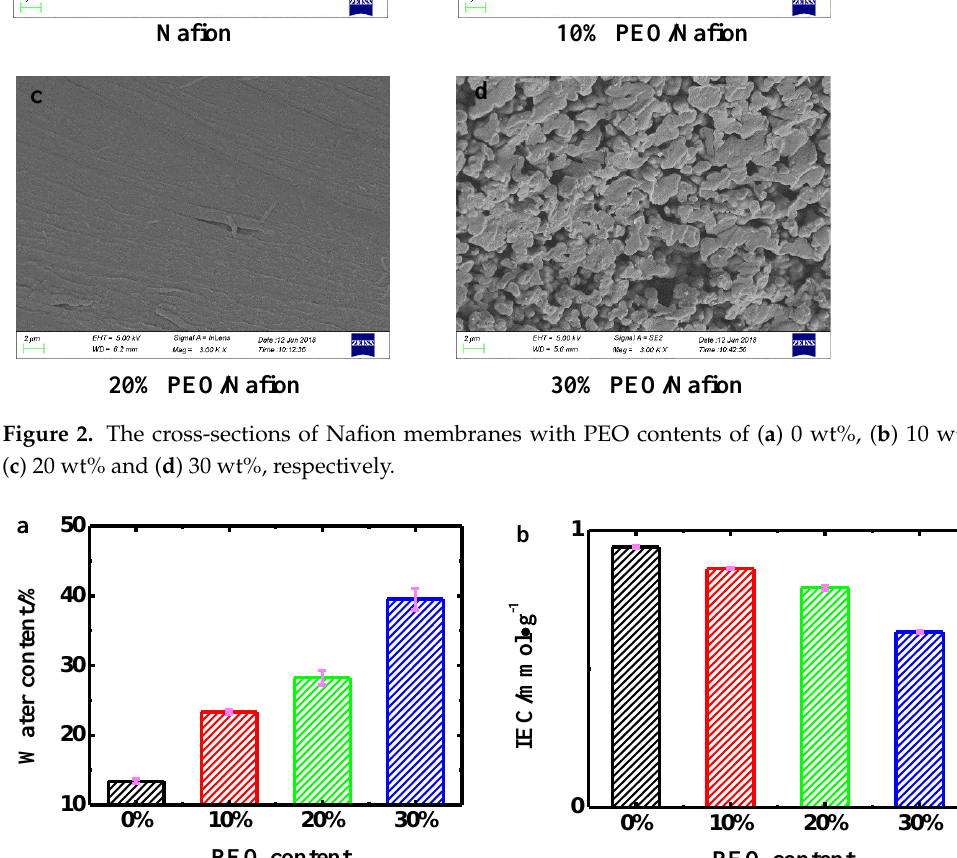
Figure 4. Equivalent stiffness of PEO/Nafion − IPMC with varying PEO contents. The deformation performance is one of the most important factors in evaluating the electromechanical performance of IPMC. Figure 5 records the peak − to − peak displacement of the PEO/Nafion − IPMC actuators under DC voltage with the amplitude of 2 V within 25 s. Obviously, doping PEO in the Nafion membrane dramatically affected the displace- ment property. Figure 6 reveals that the peak − to − peak displacements of all the PEO/Nafion − IPMCs were larger than those of the pure Nafion − IPMC due to higher WUR and lower equivalent stiffness of the PEO/Nafion membrane. It can be noticed that the average peak − to − peak displacement of PEO/Nafion − IPMC with 20 wt% PEO reached up to 11.00 mm, which was almost twice as large as that of the pure Nafion − IPMC (5.62 mm). This result indicated that the IPMC with a PEO content of 20 wt% presented the optimal deformation property from a comprehensive effect of appropriate WUR, IEC, equivalent stiffness, and homogeneous internal structure. However, a further increase in PEO con- tent resulted in decreasing the peak − to − peak displacement of PEO/Nafion − IPMC, which